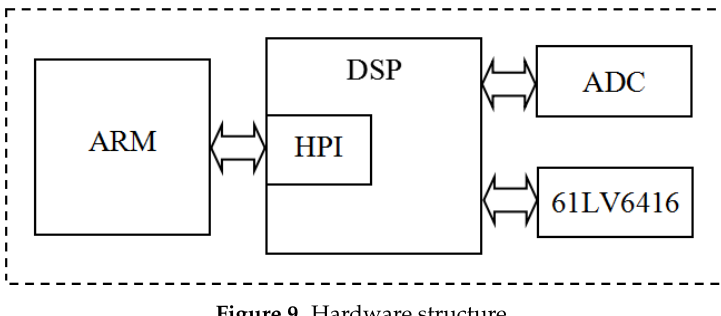
Figure 9. Hardware structure.